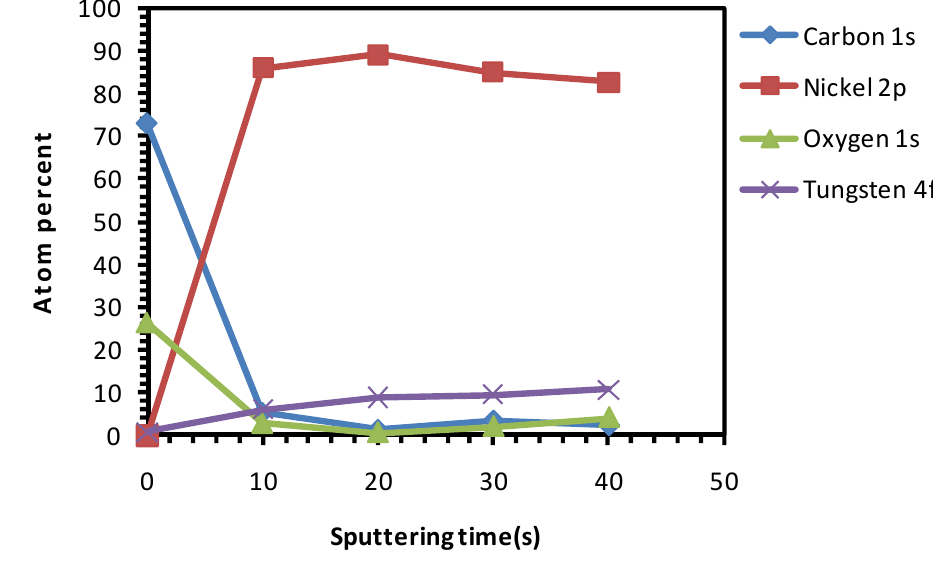
Figure 1. X-ray photoelectron spectroscopy (XPS) depth profile studies of uncleaned Ni-5% W